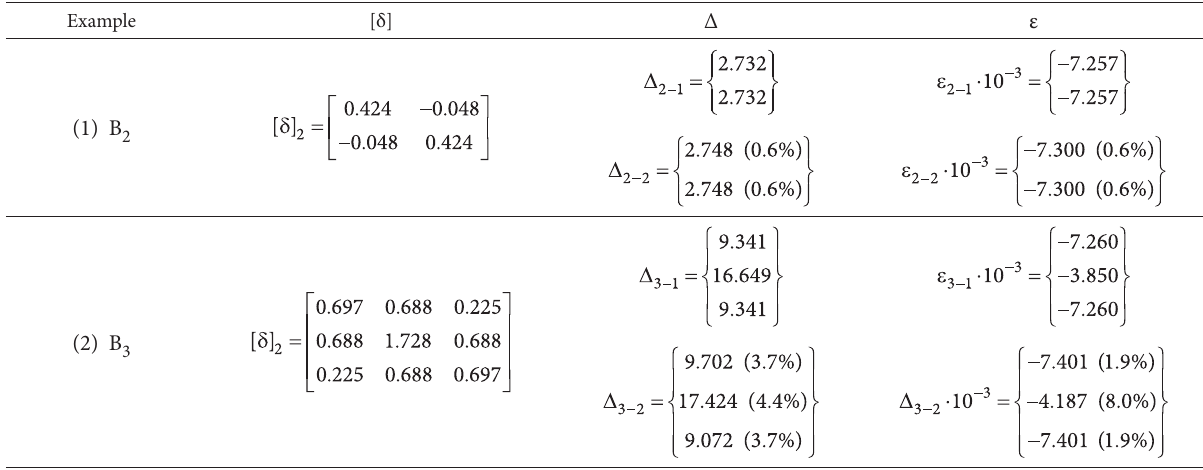
table 5. Numerical values of the parameters of the Minimal Bending Energy Criterion without (1) and including (2) the effect of the staggered erection of the superstructure for B 2 and B 3 . [δ] and Δ are in